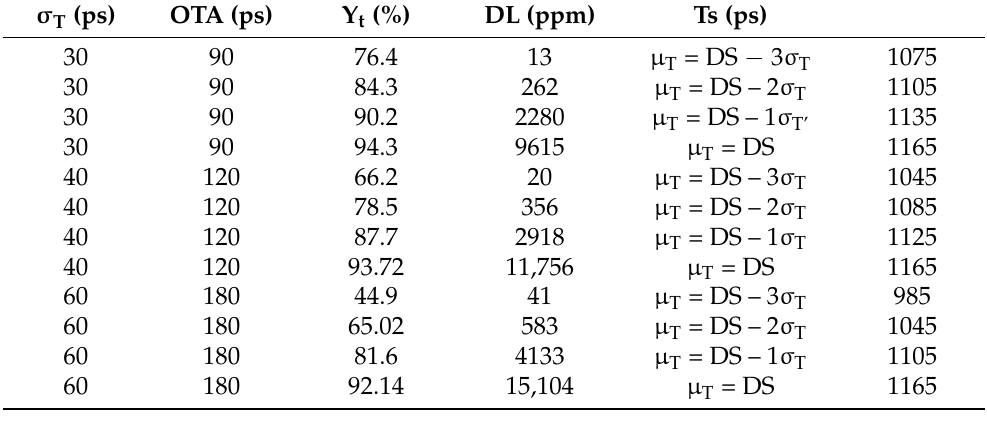
Table 2. The impact of test parameters OTA and test specifications on test results.